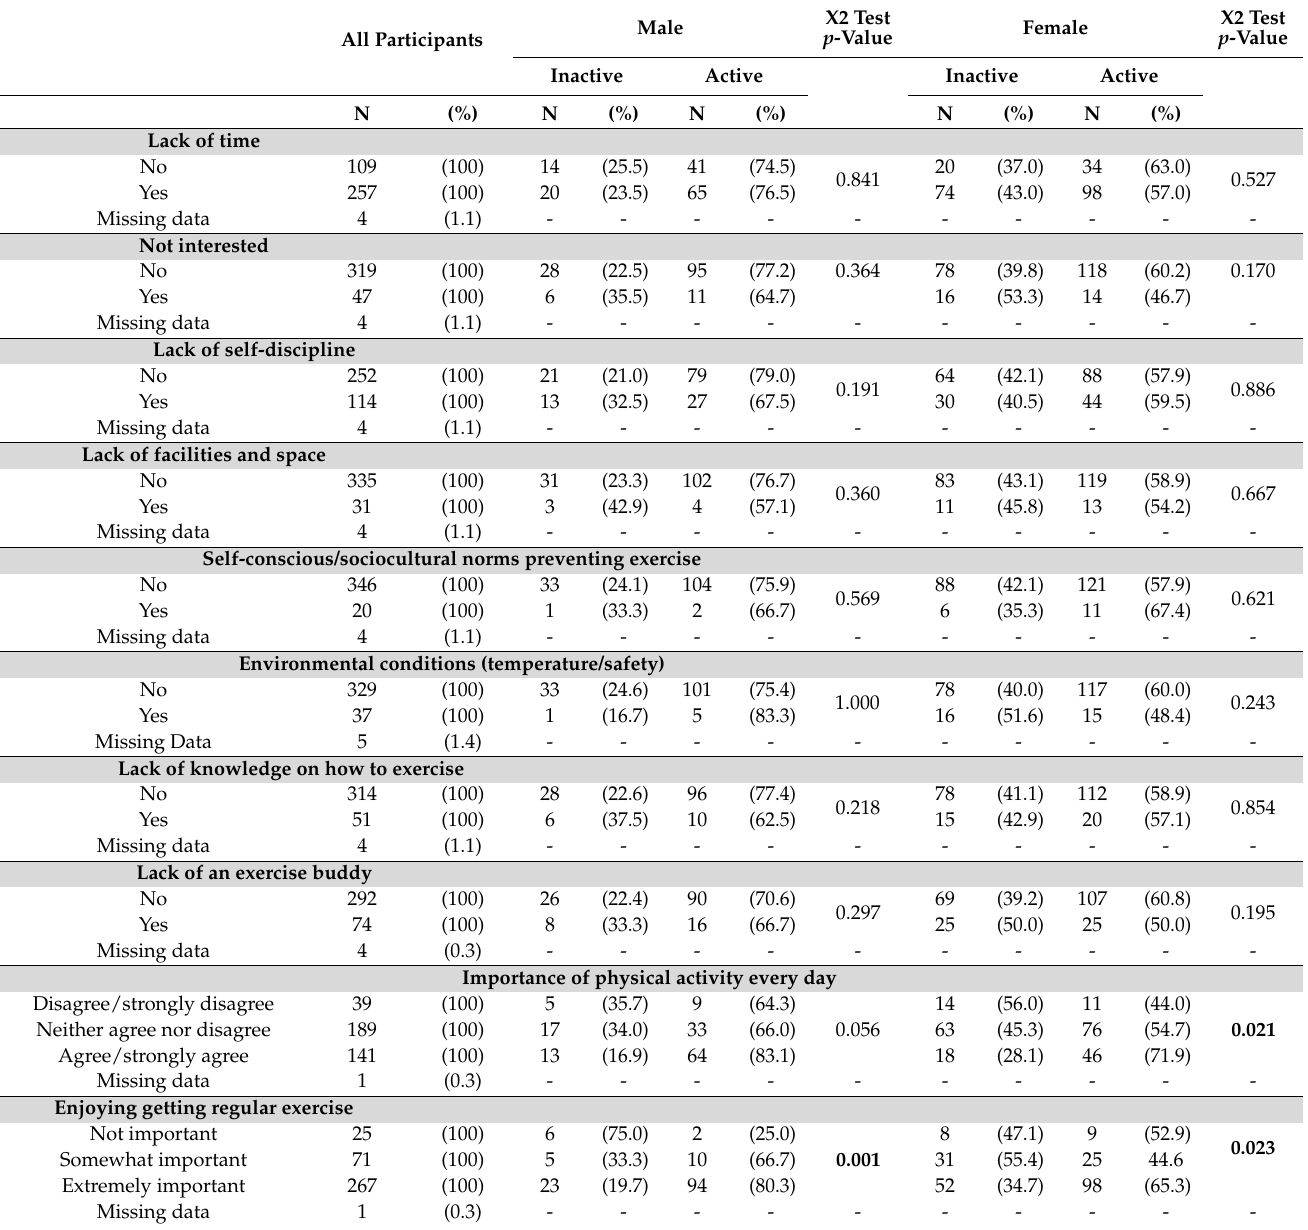
Table 6. Barriers and positive perceptions towards physical